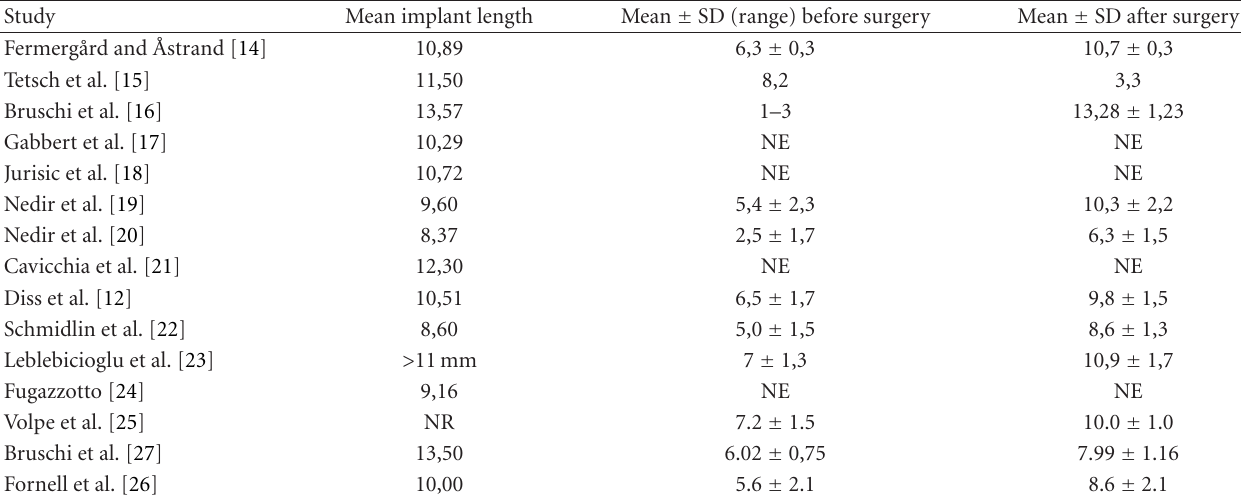
Table 2: Bone height before and after